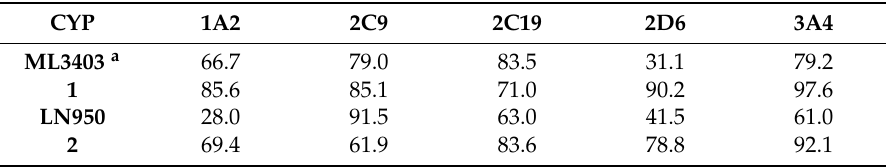
Table 2. (%) inhibition of the most important CYP isoenzymes at 10 µ